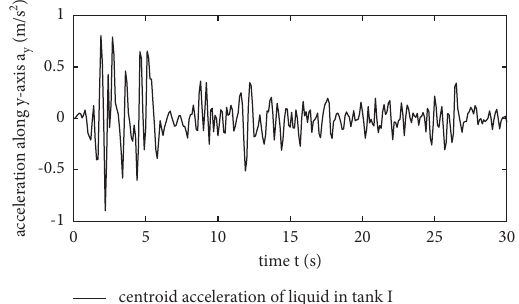
Figure 12: Acceleration curve of mass center of the liquid in tank I.